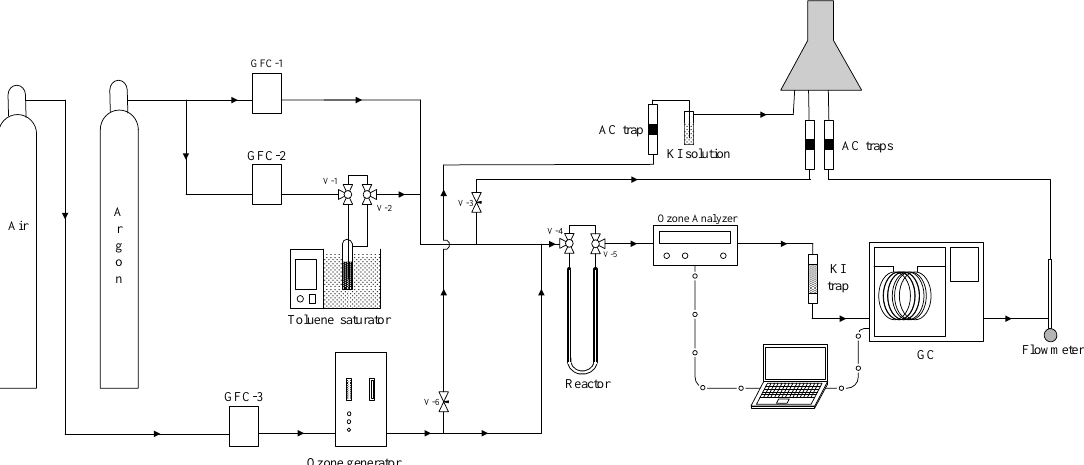
Figure 8. Experimental set-up for the catalytic ozonation of toluene using acidic surface transformed natural zeolite as catalyst at room temperature. Gas flow controllers (GFC); activated carbon (AC) traps; potassium iodine (KI) trap. Reprinted with permission from Reference [32].